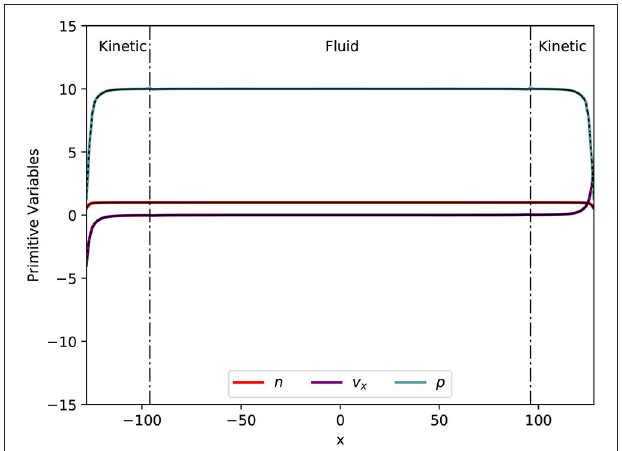
FIGURE 10 | Ion sheath density, velocity, and pressure moments at t 20 /ω p e with direct variable translation. The middle domain is solved using = the 5 N -moment two-fluid plasma model while the left and right domains are solved using the continuum kinetic two-species plasma model. Simulation results from applying the continuum kinetic model for the entire domain are plotted in black dashed lines for comparison.